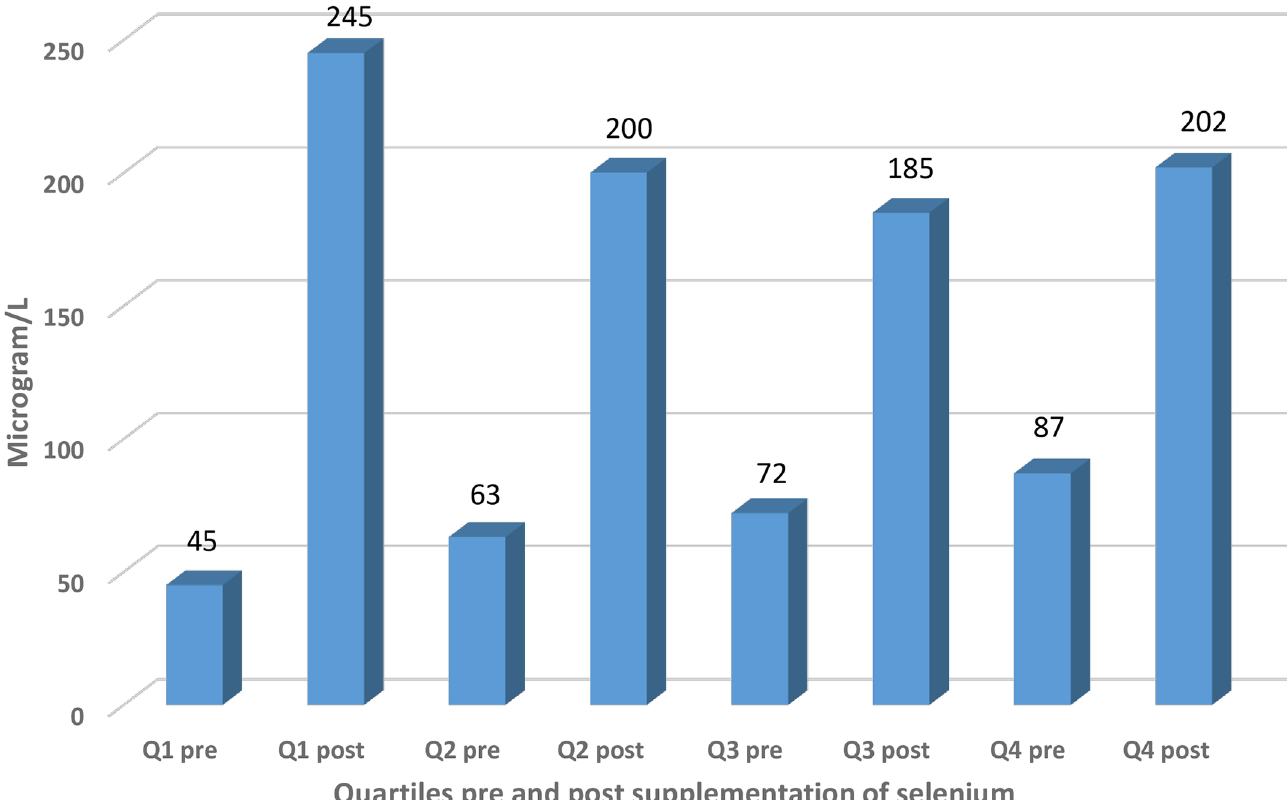
Fig 2. Histogram illustrating the mean concentration of serum selenium divided into the four quartiles based on the basal measurements, and effect of supplementation with selenium.